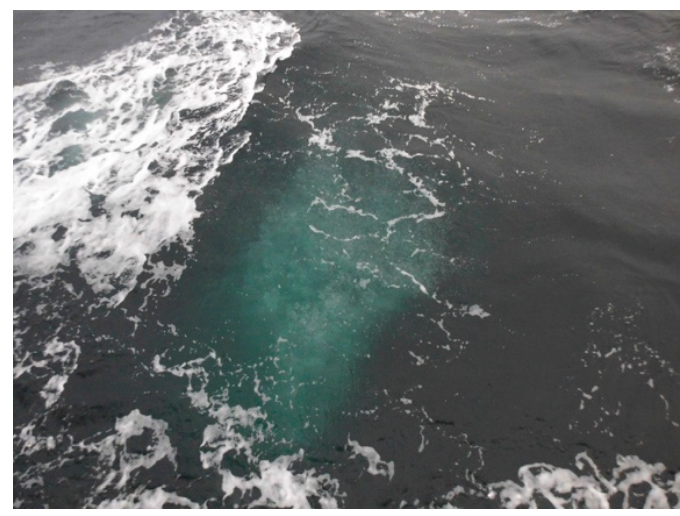
Figure 11. Gas seeps on the East Siberian shelf. Photograph by Bukhanov, October 2019.